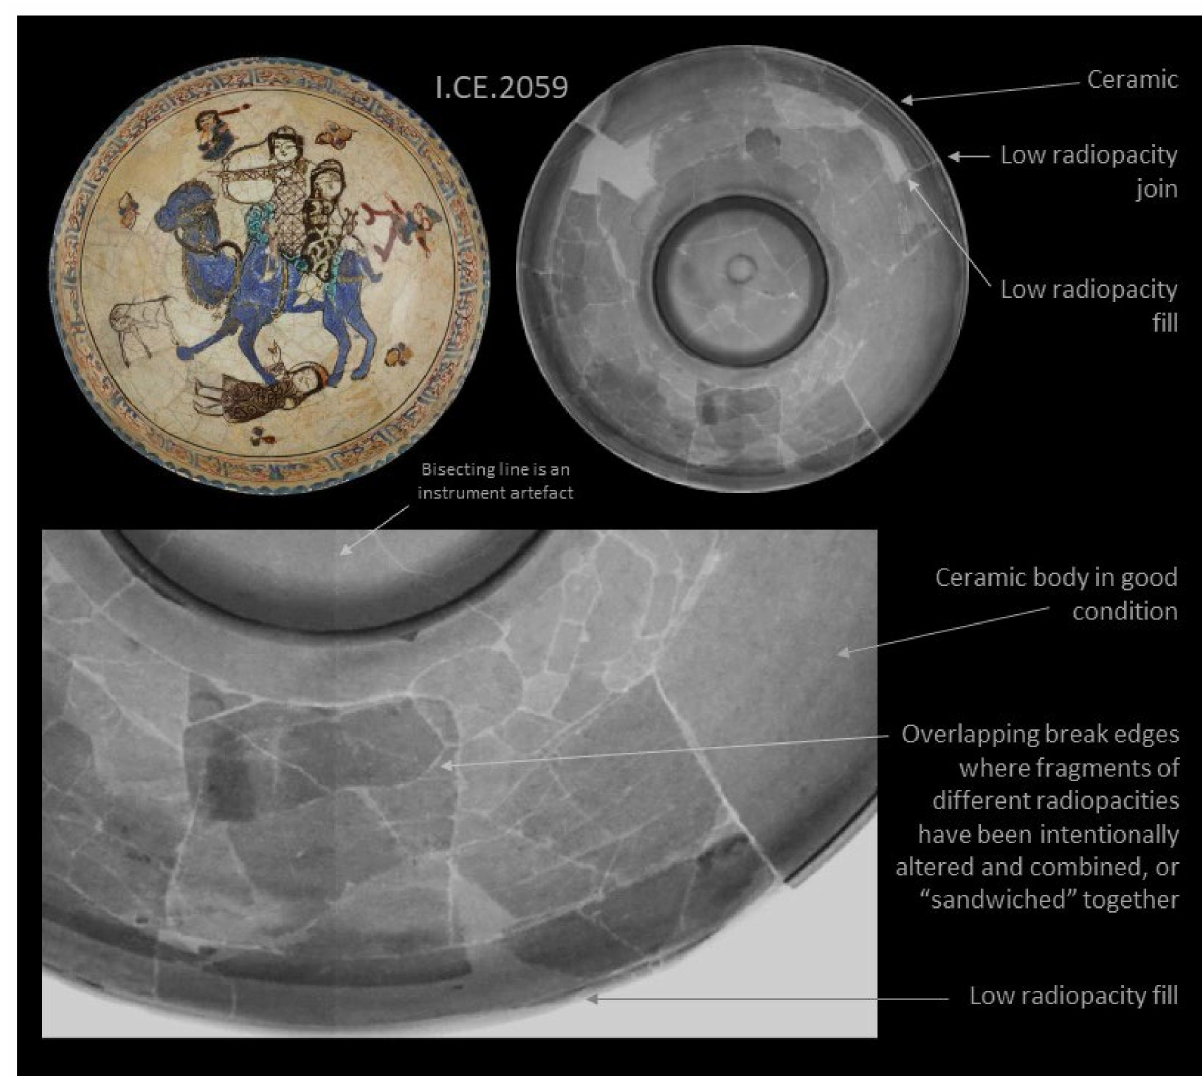
Figure 6. Results for I.CE. 2059, upper left digital photography, upper right digital radiograph, the detail below shows overlapping shards in the recumbent figure’s